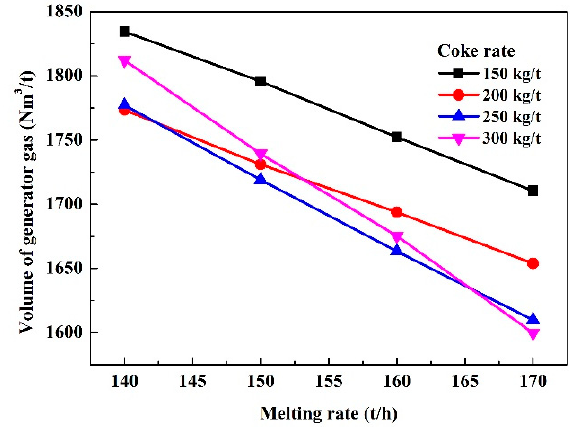
Figure 7. The volume of generator gas after COG injection.